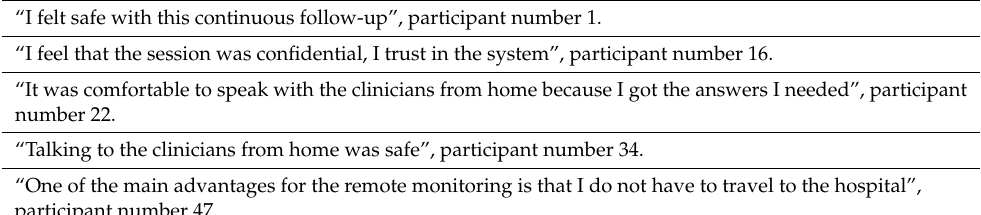
Table 6. Quotes from participants in the remote monitoring group, 12 months after